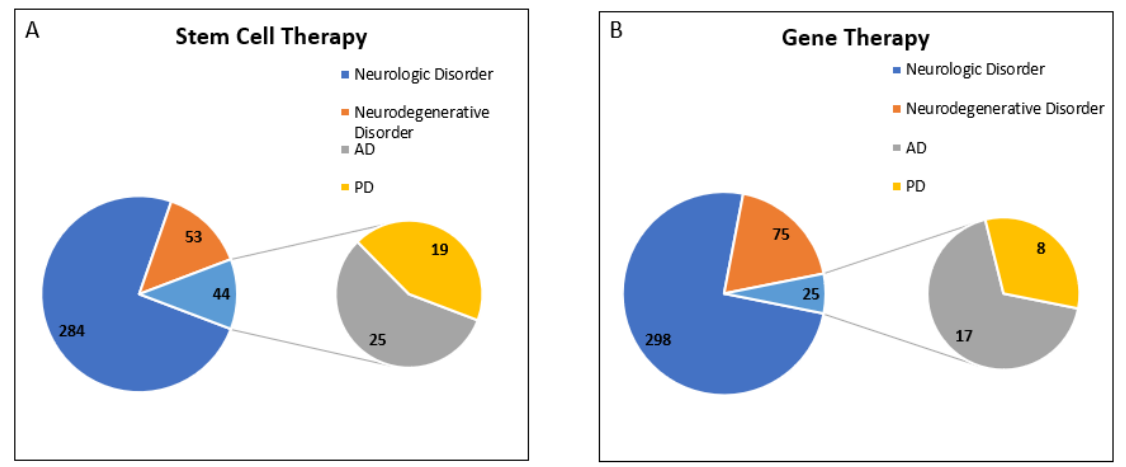
Figure 4. Registered Clinical trial for PD and AD in last decade (w.e.f. 1 January 2012 to 31 December 2021). Analysis of clinical trial data obtained from https://clinicaltrials.gov/ was conducted. Data was accessed on 18 February 2022 ( A ) Total number of clinical trials registered for neurologic disorders for stem cell therapy was 381, out of which 97 trials were for neurodegenerative disorders, including 44 clinical trials for AD and PD. ( B ) Total number of clinical trials registered for neurologic disorders for gene therapy was 398, out of which 100 trials were for neurodegenerative disorders, including 25 clinical trials for AD and